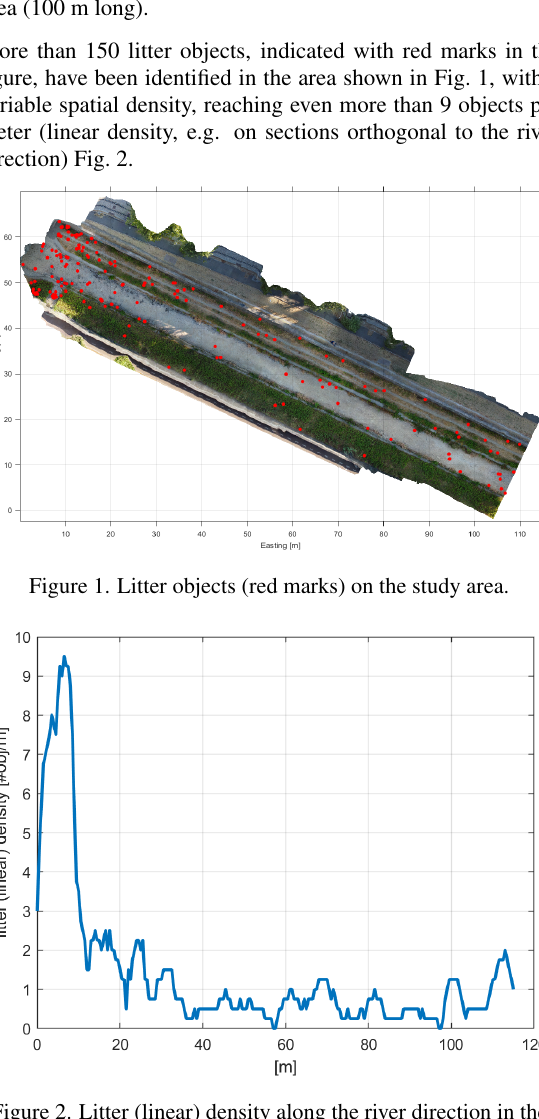
Figure 2. Litter (linear) density along the river direction in the case study area.